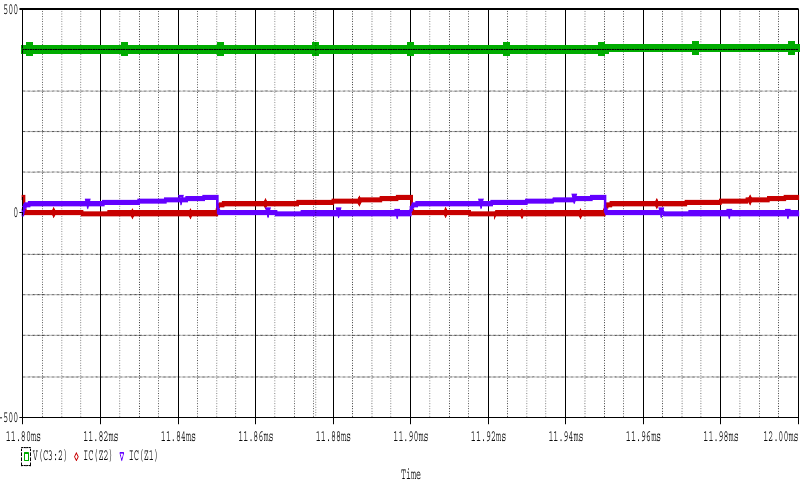
Figure 39. No-load output voltage.